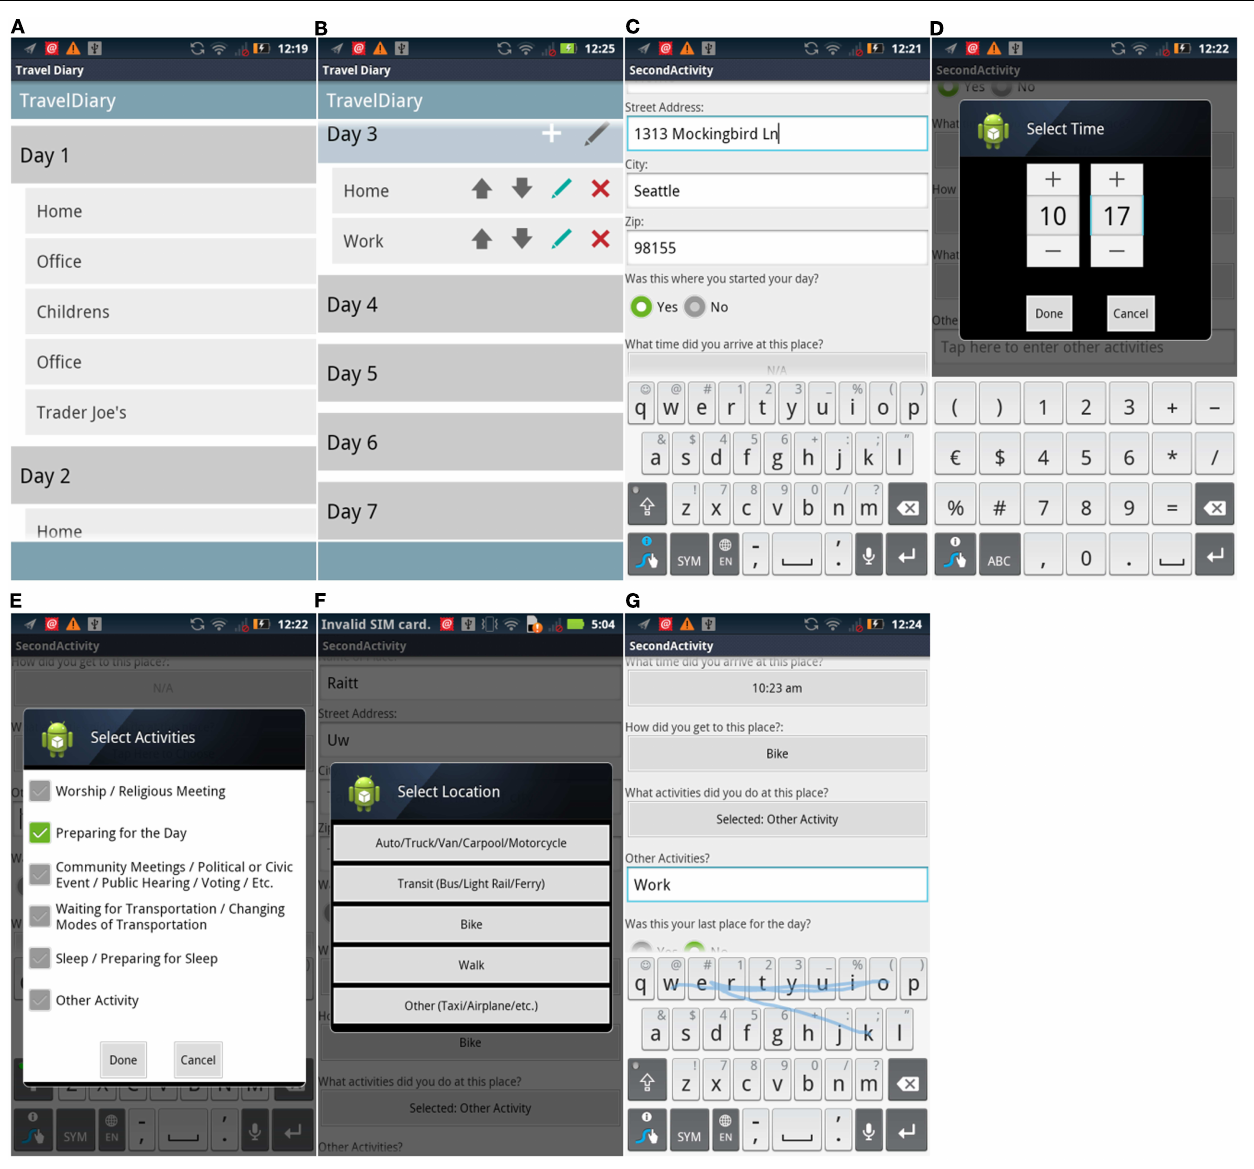
FIGURE 6 |Travel Diary screen captures . From left to right, top to bottom: (A) layout of place records; (B) editing mode for places within a day; (C) address place data entry; (D) assigning timestamps; (E) selecting activity for a place; (F) selecting predefined location; (G) entering open-ended